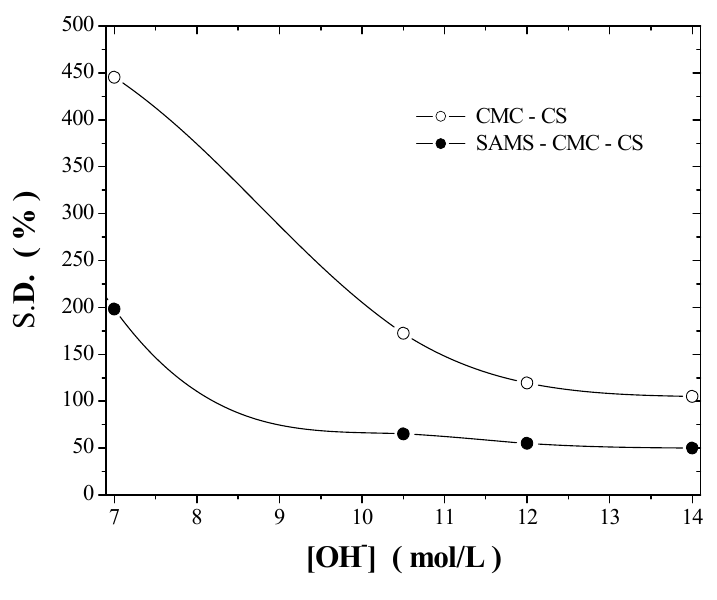
Fig. 6 Effect of [OH-] on swelling degree